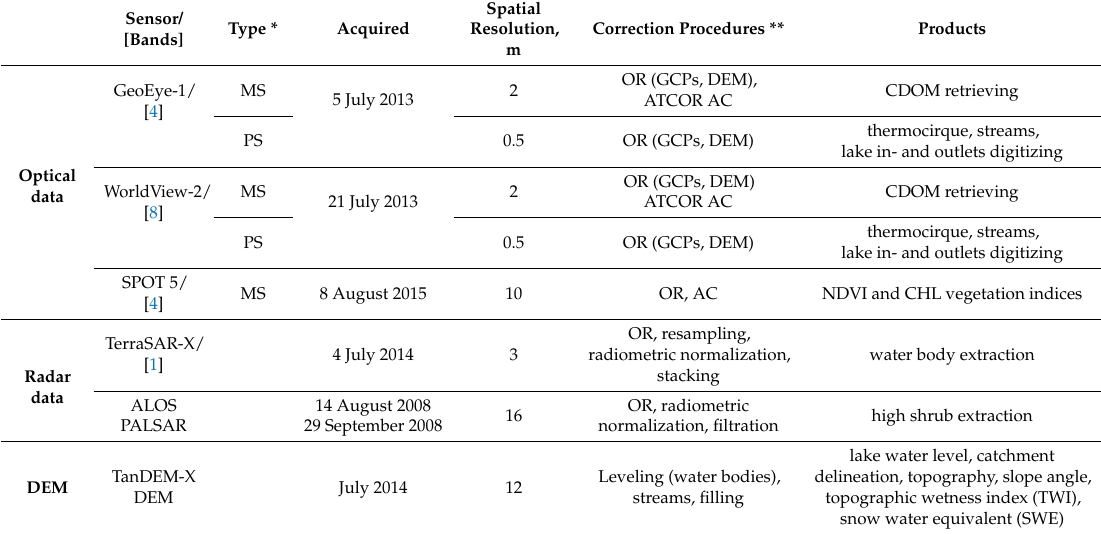
Table 2. List of remote sensing data used. * Different types of data used (MS—multispectral, PS—pan-sharpened (PANSHARP2 model, [37]); ** orthorectification (OR) applied for all optical images using collected ground control points (GCPs) in the field with Differential Global Positioning correction (AC) applied for all MS images using ATCOR© algorithm [38]. NDVI: normalized